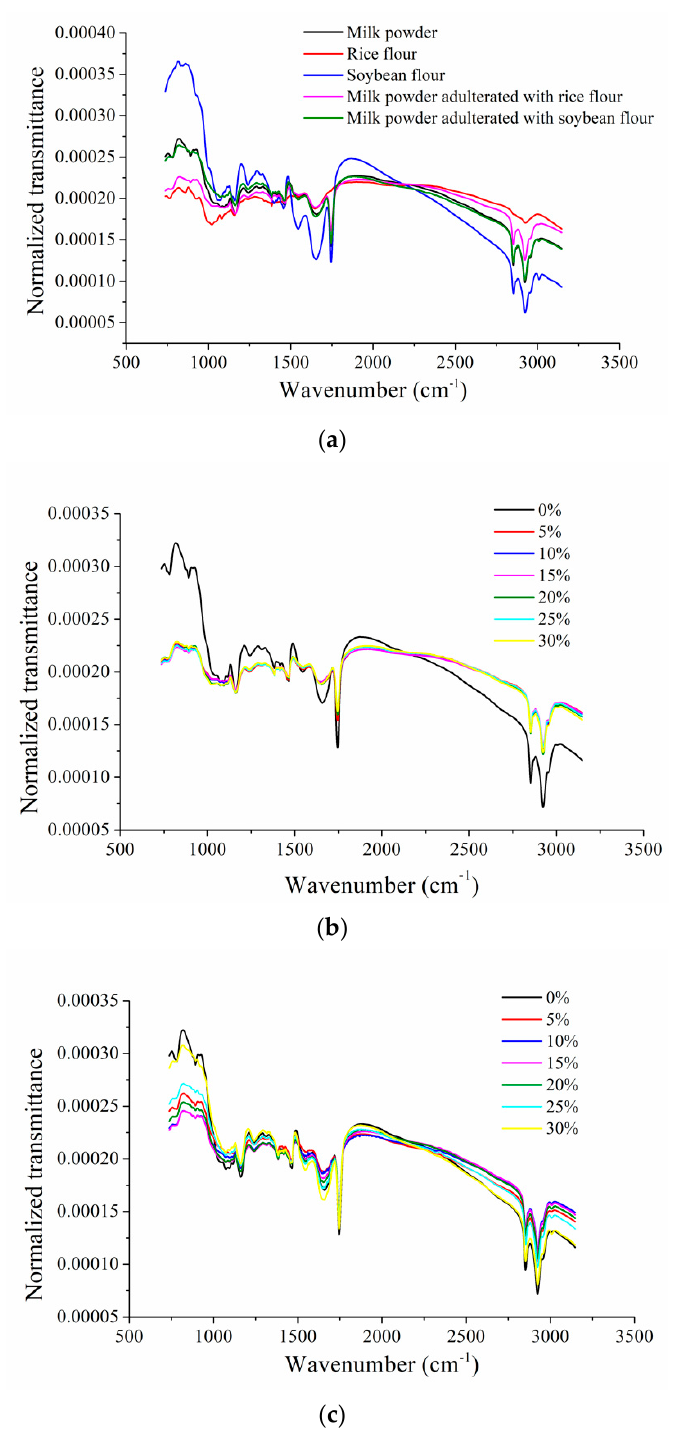
Figure 1. Average spectra of samples: ( a ) Average spectra of milk powder, rice flour, soybean flour, milk powder adulterated with rice flour and milk powder adulterated with soybean flour; ( b ) Average spectra with of milk powder adulterated with different content of rice flour (0%, 5%, 10%, 15%, 20%, 25% and 30%); ( c ) Average spectra of milk powder adulterated with different content of soybean flour (0%, 5%, 10%, 15%, 20%, 25% and 30%).